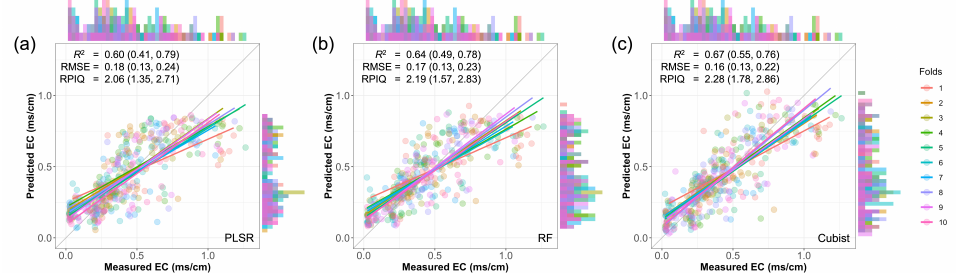
Figure 4. Observed vs. predicted soil EC with the assessment of statistics from a 10-fold cross- validation of PLSR ( a ), RF ( b ), and C UBIST ( c ) models. Values out and in brackets are mean, minimum and maximum values, respectively. The solid 1:1 line in grey is drawn for reference. Top and right histograms show the distributions of measured and predicted EC